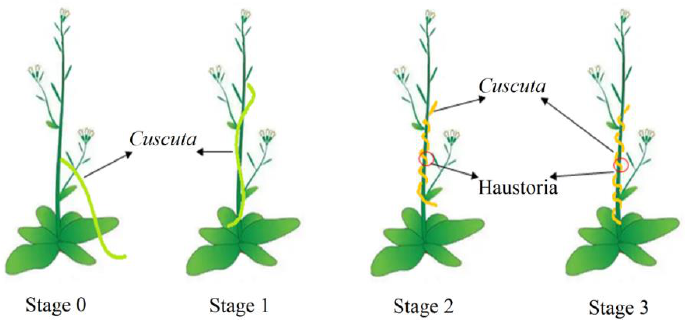
Figure 1. Stages of Cuscuta haustoria formation on Arabidopsis host Plant. Stage 0: the prehaustorial stage when Cuscuta responds to the host; stage 1: the early stage when the haustoria are inducted by the host; stage 2: the middle stage when the haustoria invade the host; stage 3: the later stage when the haustoria